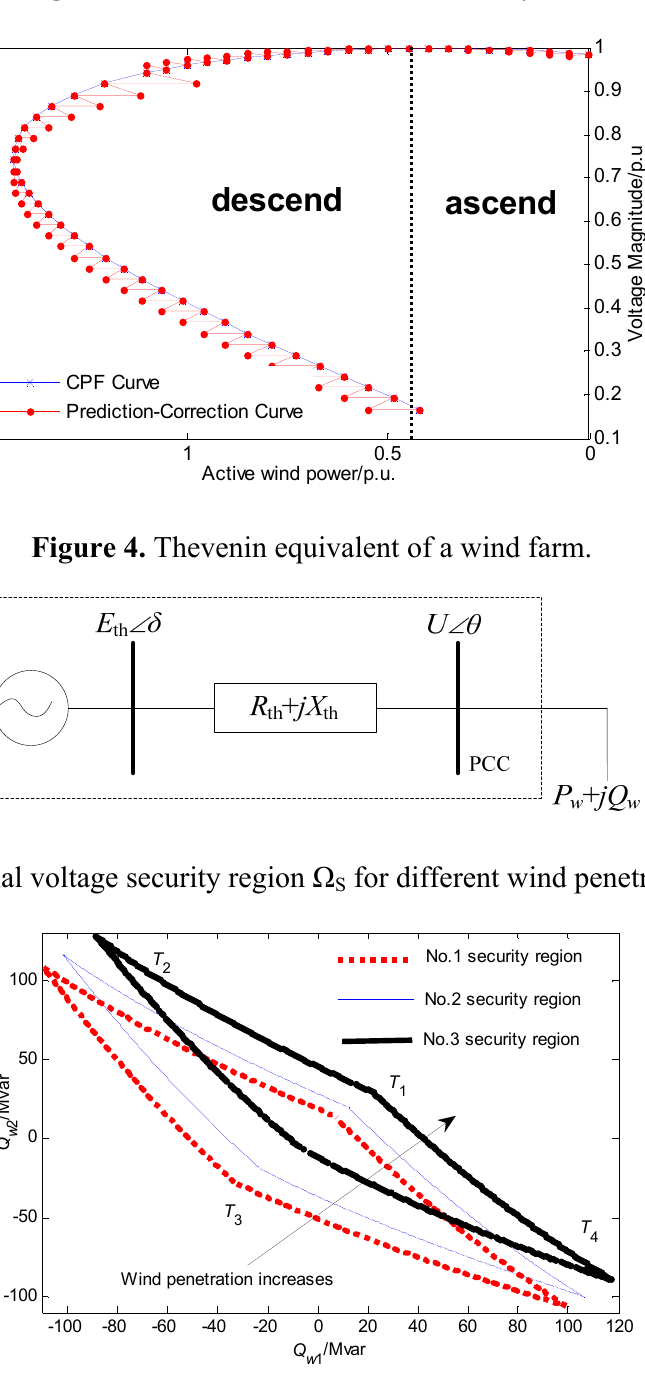
Figure 3. CPF of the PCC in a nine-bus system.